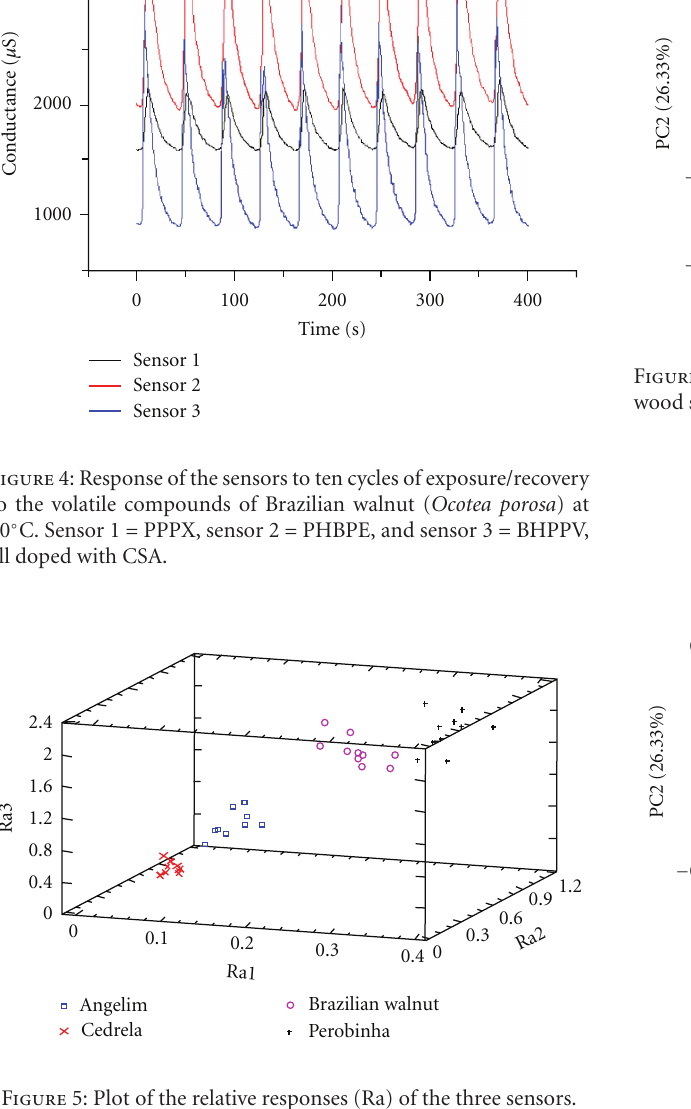
Figure 7: Bidimensional loading plots of the variables analyzed by LIBS in Figure